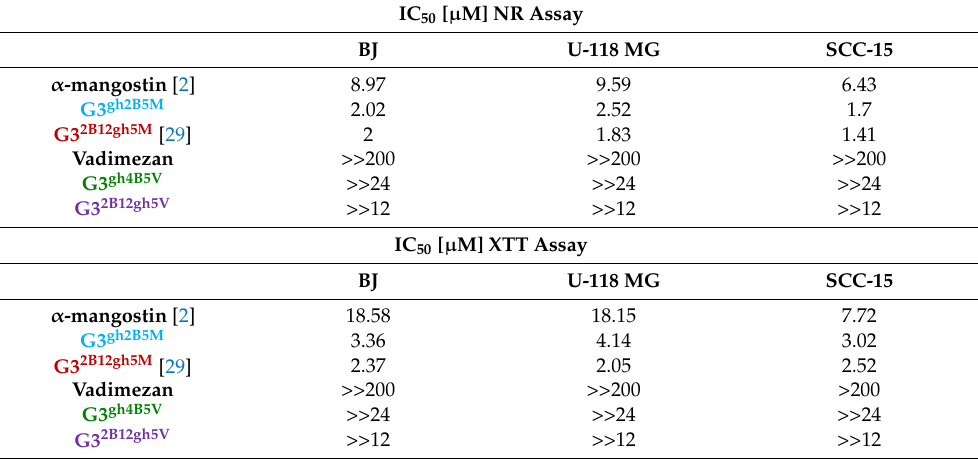
Table 2. The half maximal inhibitory concentration (IC 50 ) values estimated with NR and XTT assay after 48 h incubation of BJ, U-118 MG and SCC-15 cells with α M or V, each used either as a free drug or the dendrimer conjugate. The IC 50 values were calculated with AAT Bioquest IC 50 calculator [46]. IC 50 [ µ M] NR